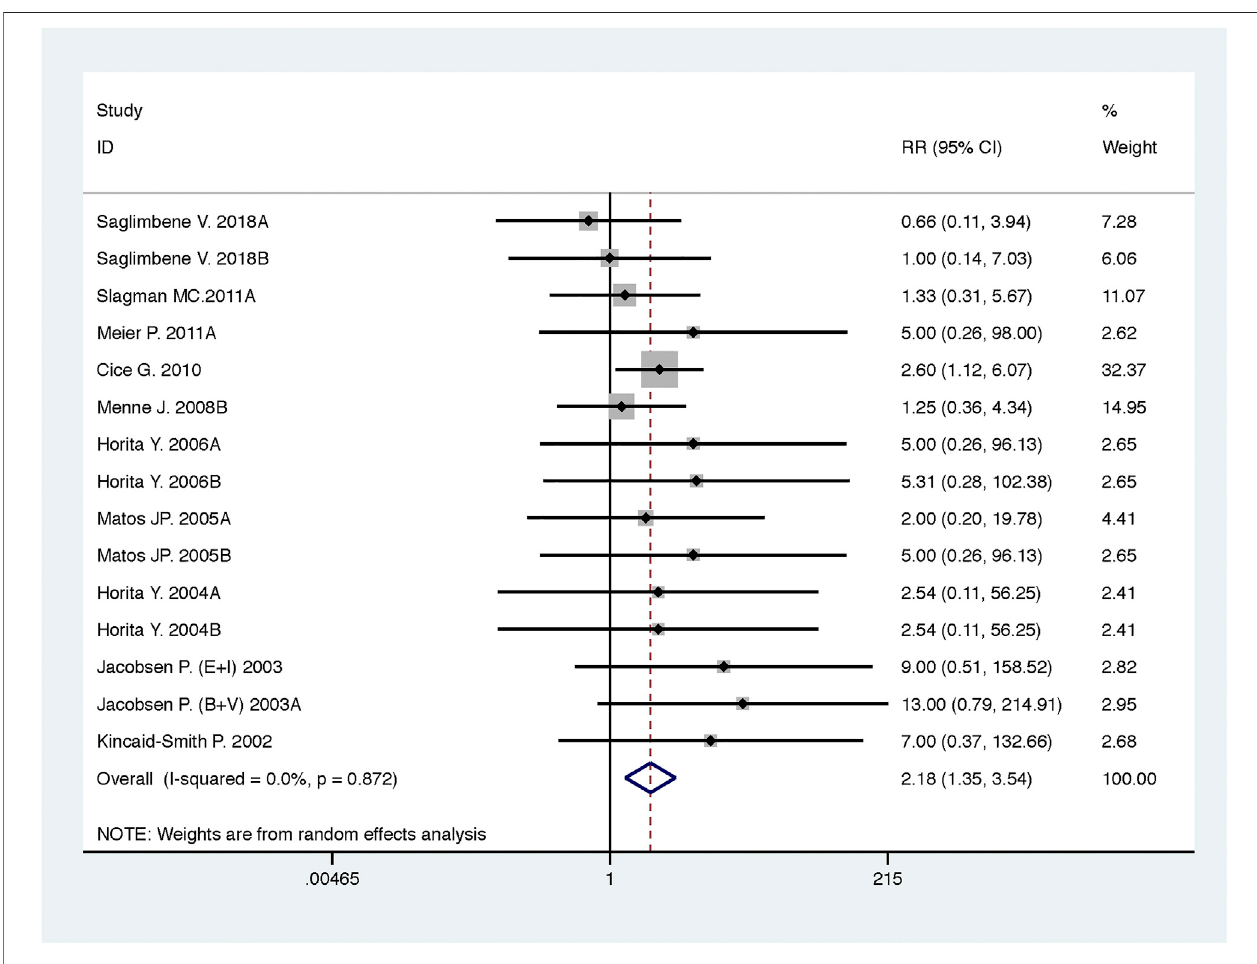
FIGURE 7 | Comparison of ACEI in combination with ARB vs. low-dose ACEI or ARB for development of hypotension.